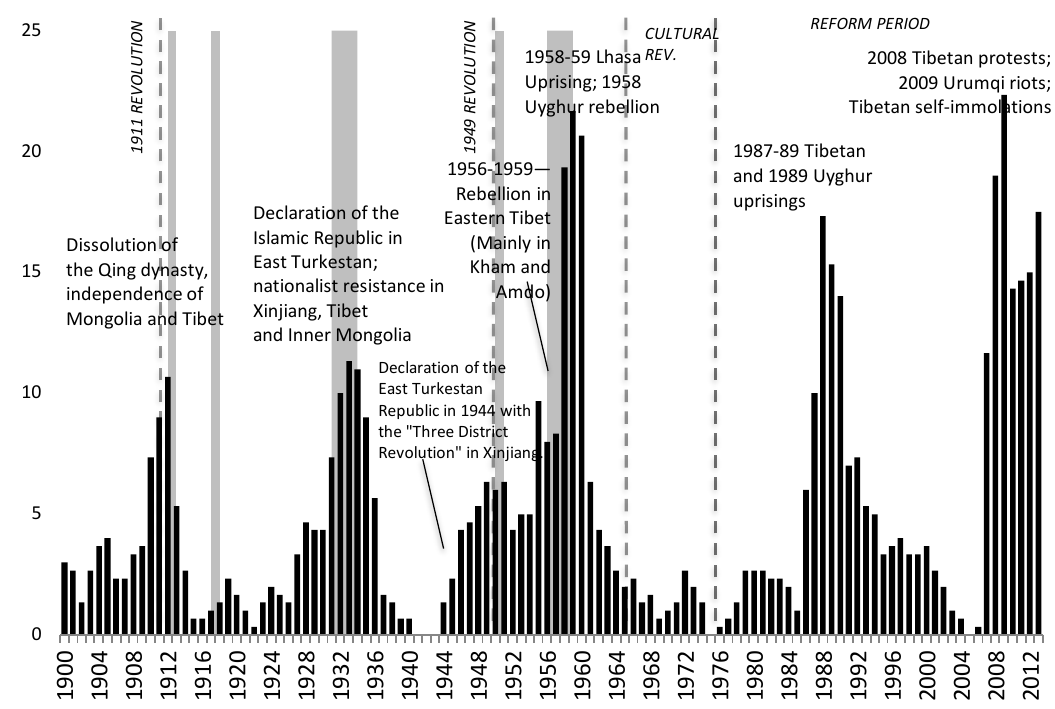
Figure 3. Patterning of Nationalist Movements in China, 1900-2013